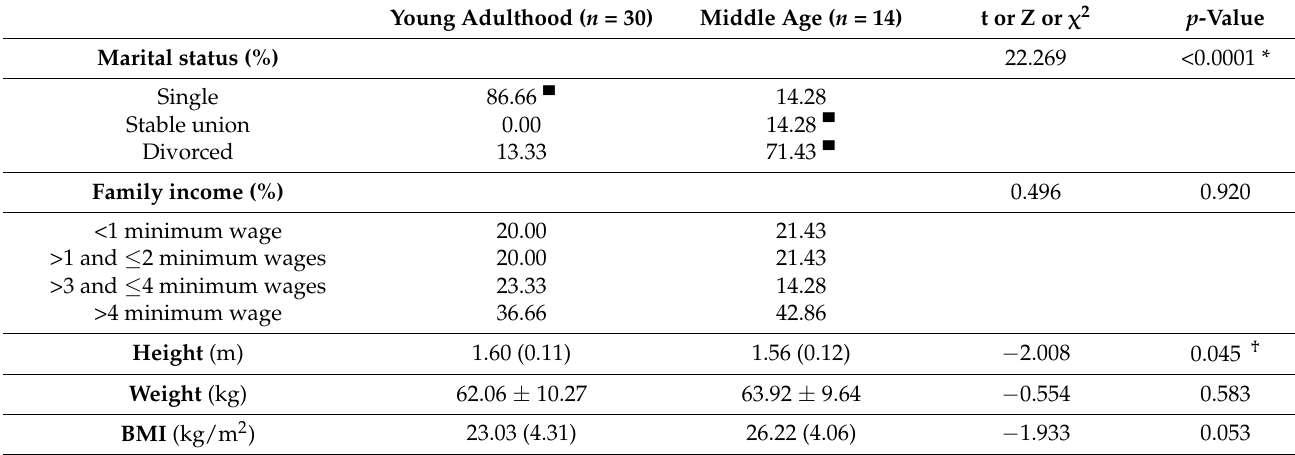
Table 1. Social and anthropometric factors in the different groups.